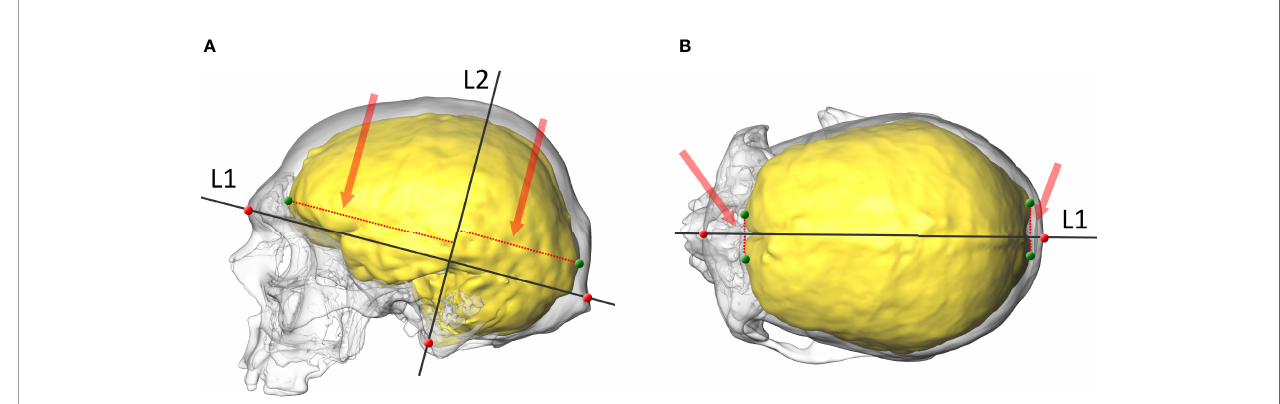
FIGURE 1 | The skull and endocast of an adult female with endocrine disorders (OL-23/77). (A) lateral view with two projected lines (L1 and L2), points on the skull (red) and the endocast (green), and the vertical dimensions of the frontal and occipital lobes (red dotted line and arrow). (B) superior view with a projected line (L1), points on the skull (red) and the endocast (green), and the lateral dimensions of the frontal and occipital lobes (red dotted line and